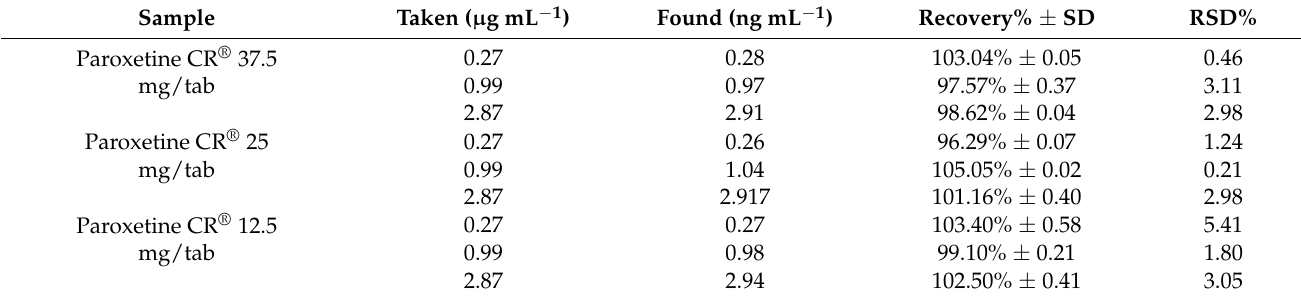
Table 2. Application of the developed sensor for the determination of PRX in pharmaceutical